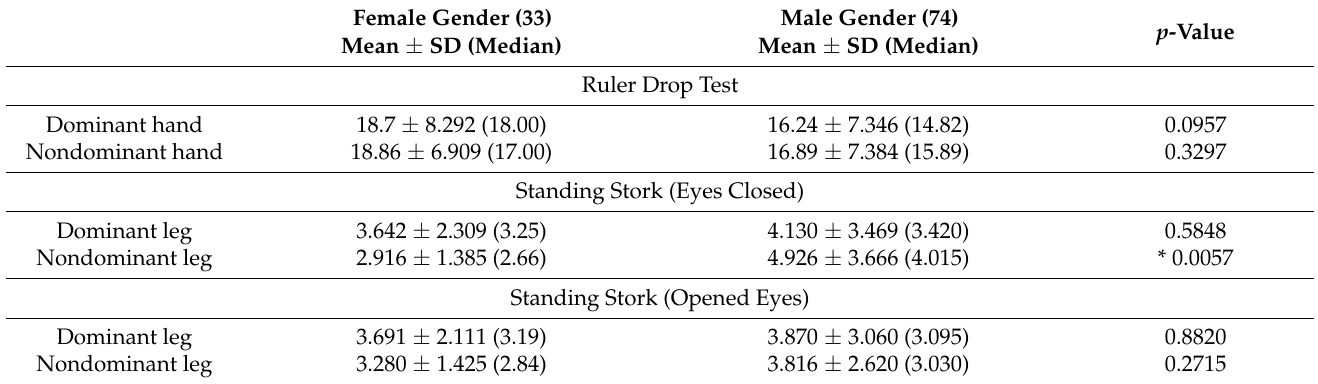
Table 1. Statistical comparison between the two